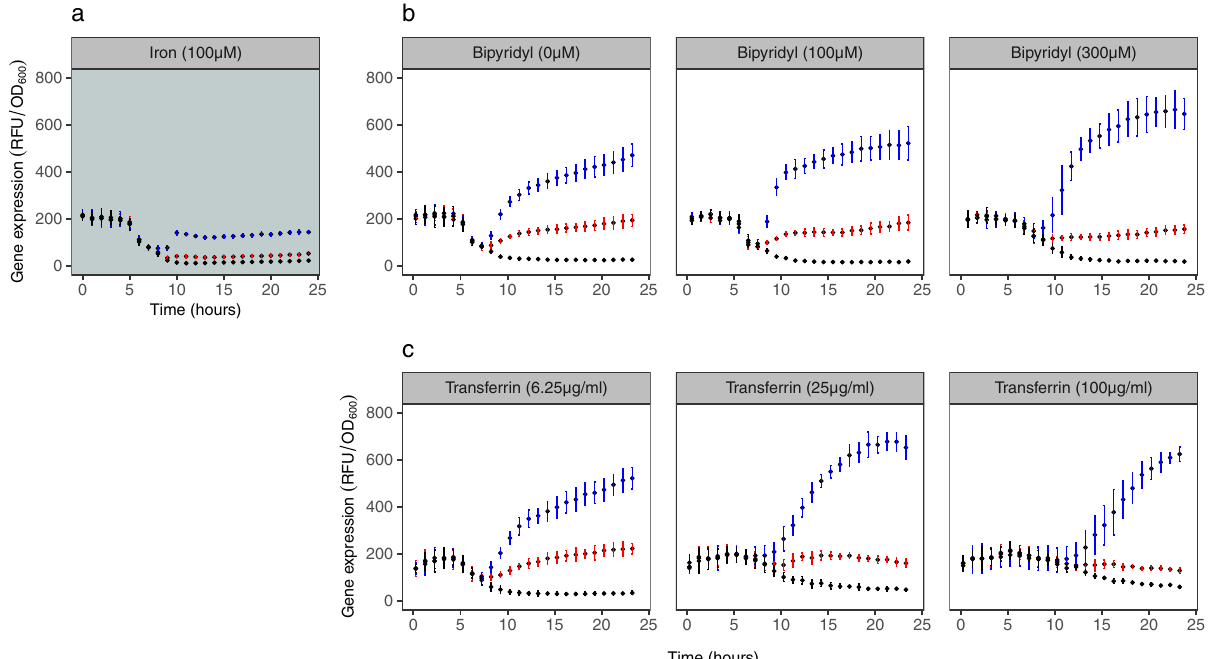
Fig. 2 Temporal dynamics of siderophore reporter gene expression at the population level. The panels show reporter gene expression for pyochelin (red: PAO1 pchEF : mcherry ), pyoverdine (blue: PAO1 pvdA : mcherry ), and the wildtype control strain (black: PAO1 without reporter fusion) across a range of CAA media differing in their level of iron limitations. Values represent normalized gene expression (relative fl uorescence units (RFU) divided by OD600) in: a iron-replete CAA medium (100 µ M FeCl 3 ); b CAA media with increasing concentrations of the iron chelator bipyridyl; c CAA media with increasing concentrations of the iron chelator apo-transferrin. Values and error bars represent the mean and standard deviation across 8 replicates (2 experiments with 4 replicates each), respectively. The in fl ation of normalized gene expression in the early hours of the growth can be attributed to divisions by very low OD600 values (close to zero) in this growth phase. Gene expression patterns started to segregate from the control PAO1 strain upon entering the exponential growth